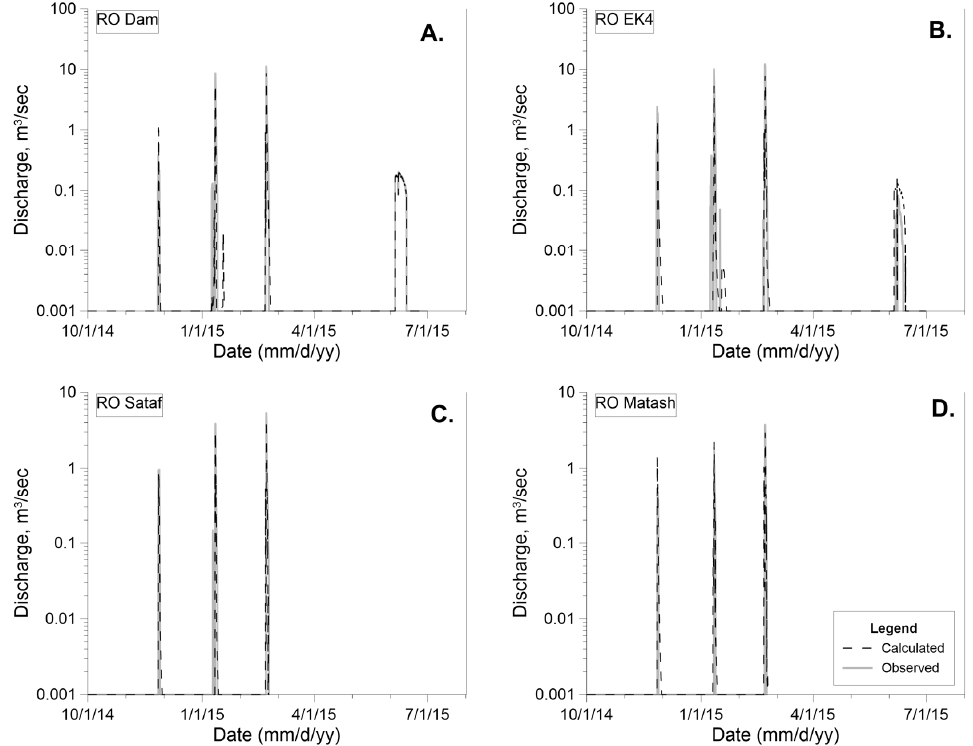
Figure 4. Observed and computed discharge at the ( A ) RO Dam; ( B ) RO EK4; ( C ) RO Sataf; and ( D ) RO Matash gauging stations.